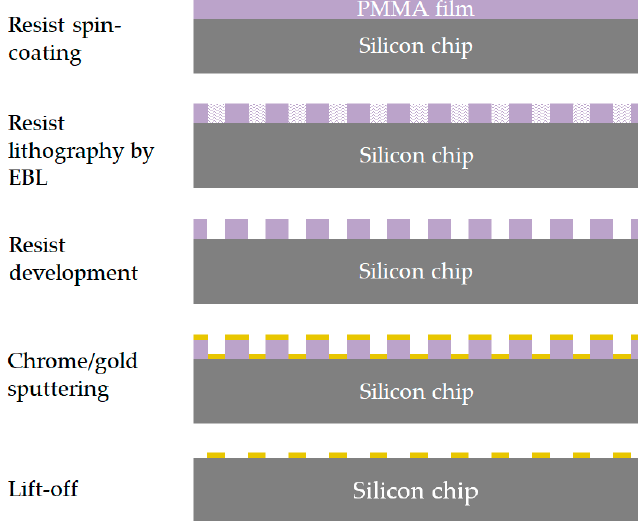
Figure 2. Schematic illustration of the fabrication process.